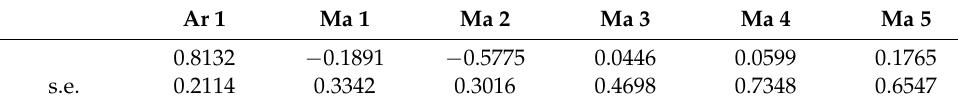
Table 13. Coefficients.